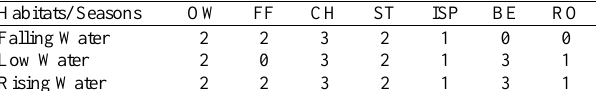
Table 2. Number of sampling sites per habitat during each hydrological season. Habitat abbreviations are: OW –